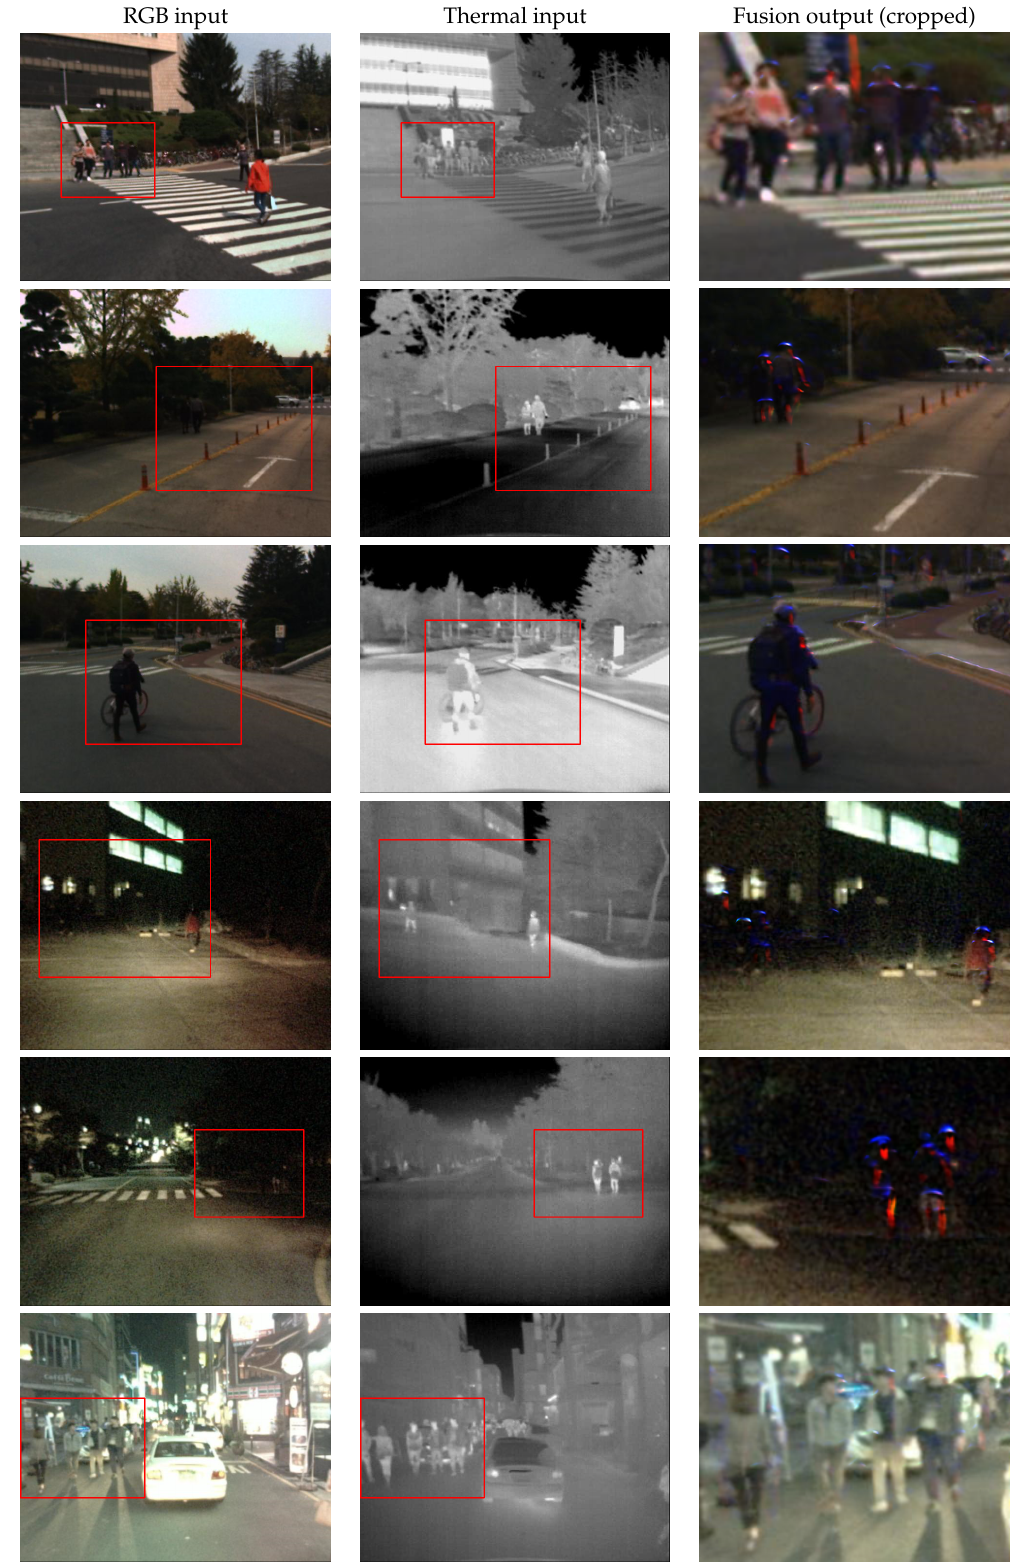
Figure 5. Daytime and nighttime examples of the inputs from the KAIST dataset and the corresponding fused outputs obtained with the proposed